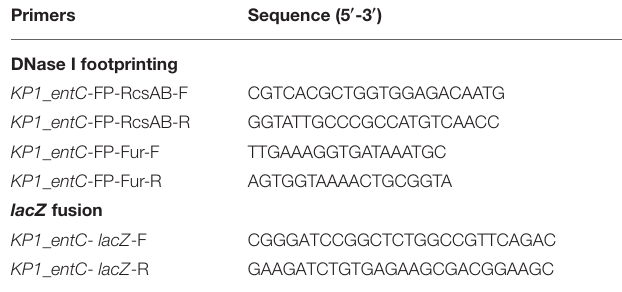
TABLE 2 | Oligonucleotide used in this